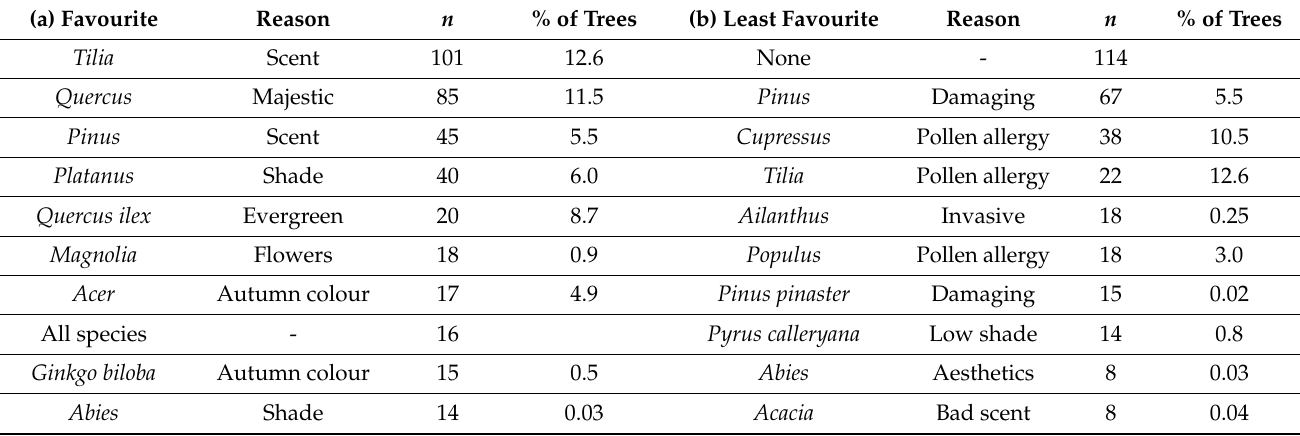
Table 1. Frequency table for the top twenty genus or species of (a) favourite and (b) least favourite urban tree with the most frequent reason given and the proportion found within the public tree database for